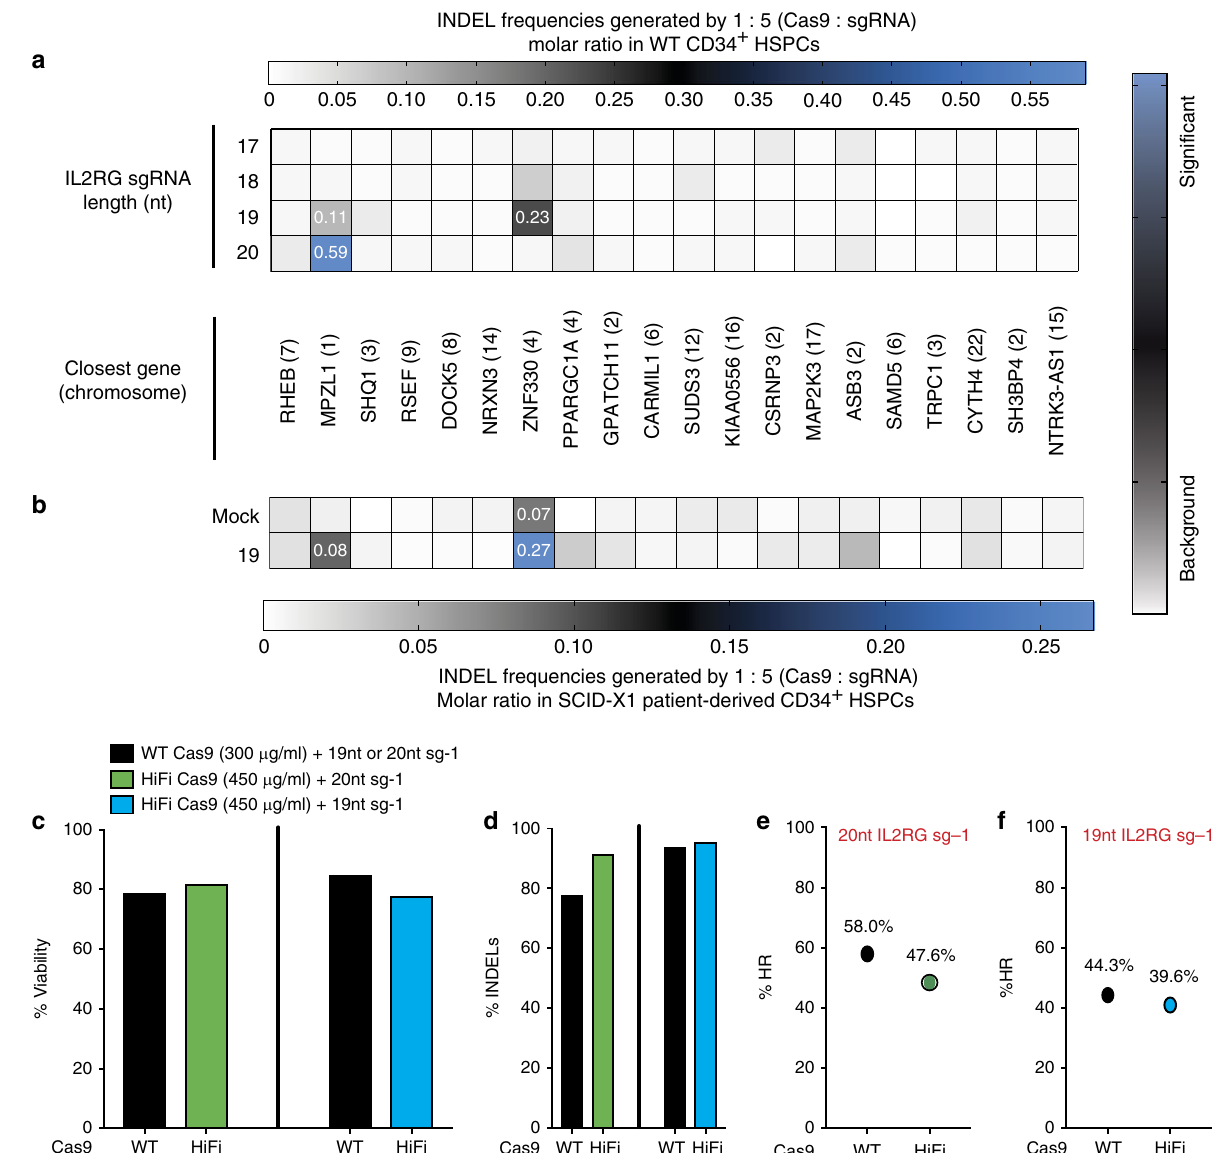
Fig. 6 Genome speci fi city of IL2RG sgRNA guide. a Heat map of on-target INDEL frequencies quantied by NexGen-Seq at COSMID identi fi ed putative on- target locations from healthy CD34 + HSPCs. Levels of NHEJ induced by 20 nt IL2RG sgRNA and truncated 19 nt, 18 nt and 17 nt pre-complexed with WT Cas9 protein at 5:1 molar ratio. b Heat map as in ( a ) of on-target INDEL frequencies derived from 19 nt IL2RG sg-1 in the genome of CD34 + HSPCs SCID-X1 patient 1 derived cells. c Percent viability at day 4 of SCID-X1 patient-derived CD34 + HSPCs nucleofected with either wild-type (WT) or high- fi delity (HiFi) SpCas9 protein pre-complexed with either the 20 nt or the 19 nt IL2RG sg-1 ( n = 1). d Percent INDELs measured by TIDE at day 4 in cells as in ( c ) using WT or HiFi Cas9 protein pre-complexed with the 20 nt IL2RG sg-1 (green bars) or 19 nt IL2RG sg-1 (blue bars). e Percent IL2RG cDNA targeting (% HR) as measured by ddPCR at day 4 in cells as in ( c ) generated by either WT or HiFi Cas9 protein pre-complexed with the 20 nt IL2RG sg-1 or ( f ) 19 nt IL2RG sg-1. Source data are available in the Source Data fi